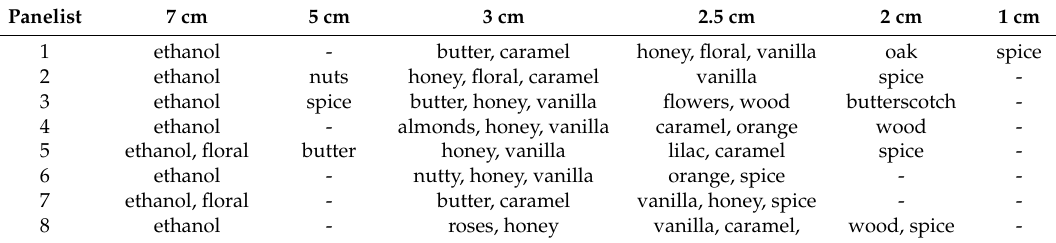
New aromas detected in bourbon as nose moves closer to liquid surface. Determined empirically, 2.5 cm is the maximum critical distance for complete aroma detection. Fluid levels were adjusted to decrease distance between liquid surface and rim plane in a large graduated tumbler. Panelists recorded new smells detected at each level. Tests were repeated with different control spirits yielding similar results. The control spirit shown is a common 40% ABV bourbon. See Section 2, Methods. Distances above 2.5 cm significantly affect aroma